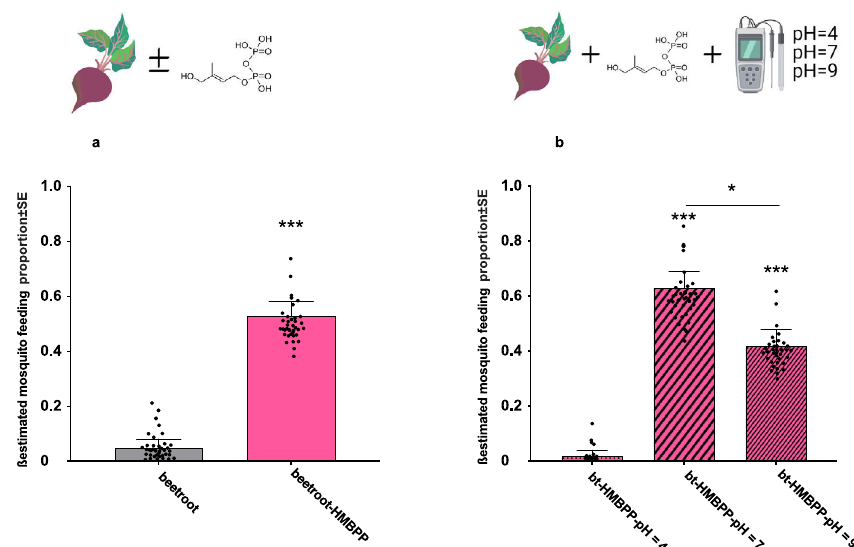
Fig. 2 Mosquito feeding on a plant-based solution based on beetroot juice containing phagostimulant, HMBPP adjusted to various pH. a Percentage of An. gambiae s.l. feeding within ten minutes on beetroot juice with and without HMBPP (beetroot vs beetroot-HMBPP χ 2 1 = 12.05, p < 0.001). b Percentage of An. gambiae s.l. mosquitoes feeding within ten minutes on plant-based solution containing HMBPP (bt-HMBPP) with three different acidity levels (bt- HMBPP-pH = 4, bt-HMBPP-pH = 7 and bt-HMBPP-pH = 9). Each bar shows a different treatment which shows by the description written under each bar. Bars represented by β -estimation generated by the mixed model ± SE ( β -lmer ± SE ) ; asterisks denote signi fi cant differences ( n = 120, * p < 0.05, ** p < 0.01, *** p < 0.001).